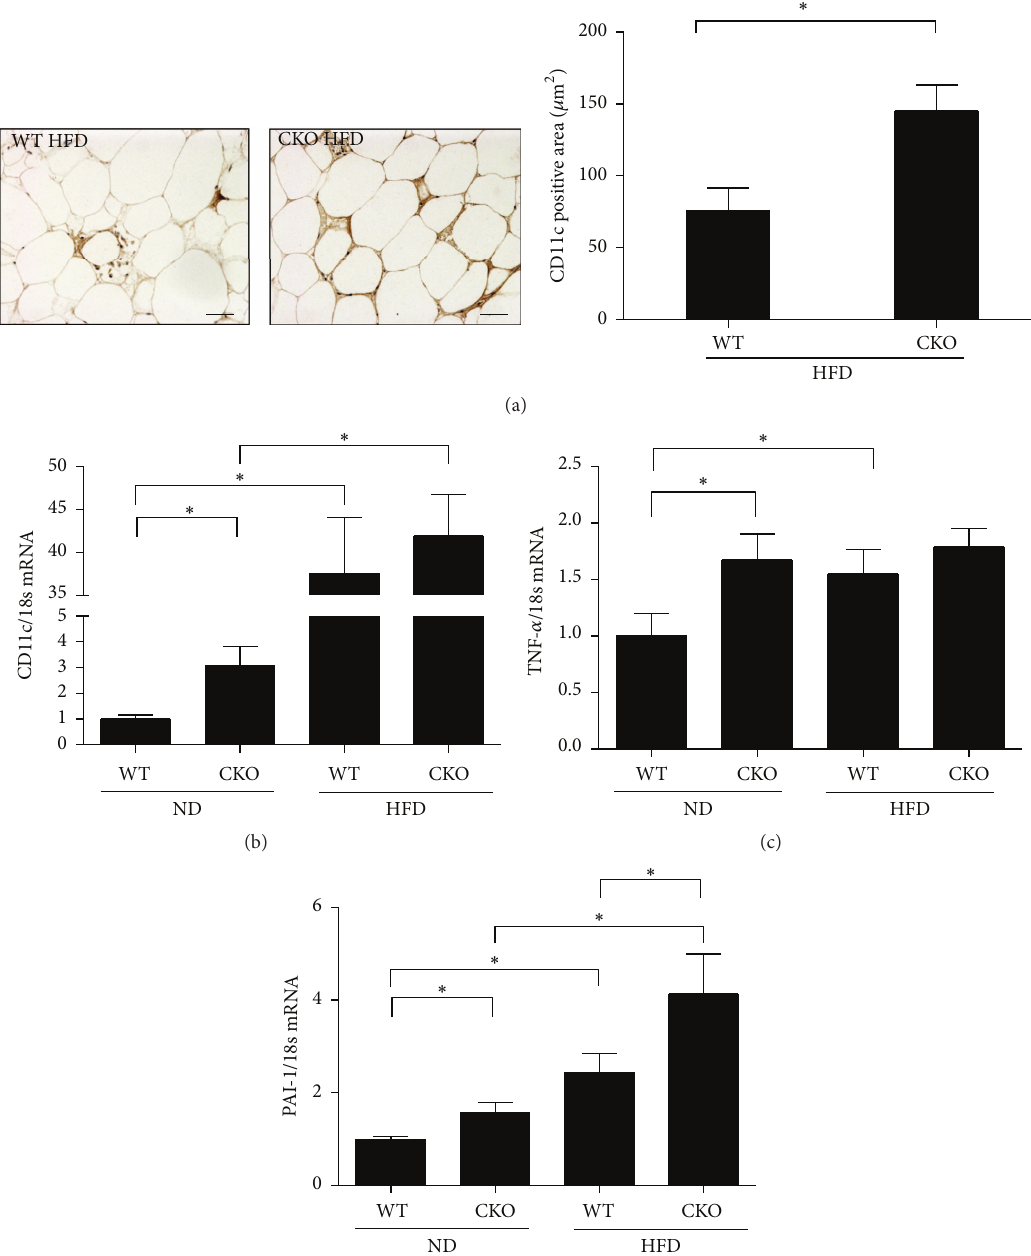
Figure 2: Catalase deficiency favors M1 activation and inflammation in the stromal vascular fraction of epididymal WAT. (a) To measure M1 activation, CD11c (1: 200) was assessed by immunohistochemistry (brown) and quantified in Image Pro. Scale bar, 50 𝜇 m; magnification, 200x. Samples were costained with hematoxylin (blue). (b) CD11c, (c) TNF- 𝛼 , and (d) PAI-1 mRNA levels were determined by real-time PCR. Data are mean ± SE of 6–8 mice. ∗ 𝑝 < 0.05